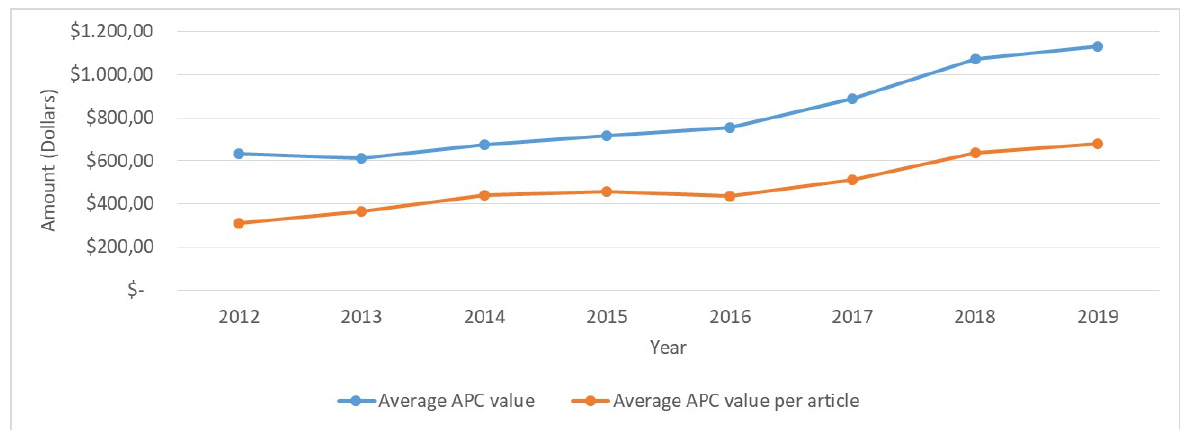
Figure 2. Average APC cost from journals and average amount spent on APCs per article in the 2012-2019 period. (Source: the